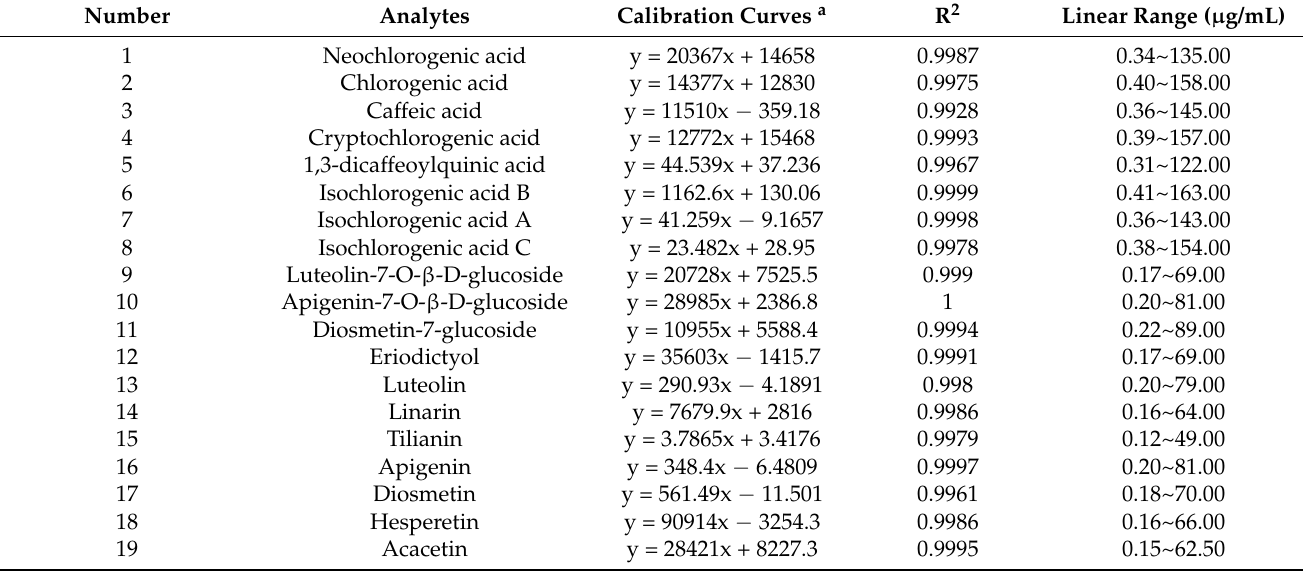
Table 1. A linear relationship between peak area and concentration of reference